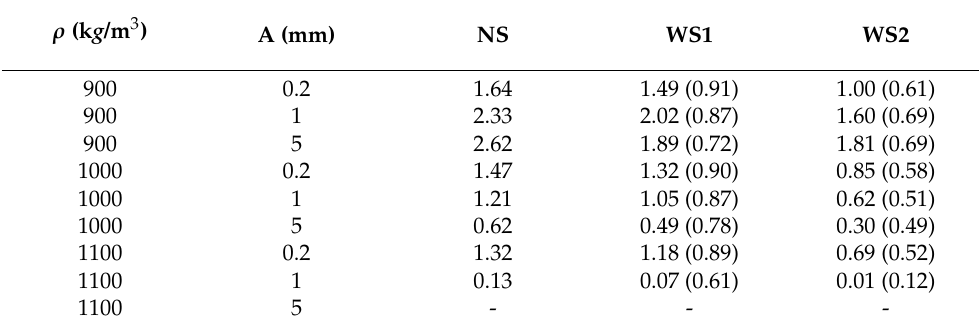
Table 2. Residence time ratio ( τ = t r,d /t r,u